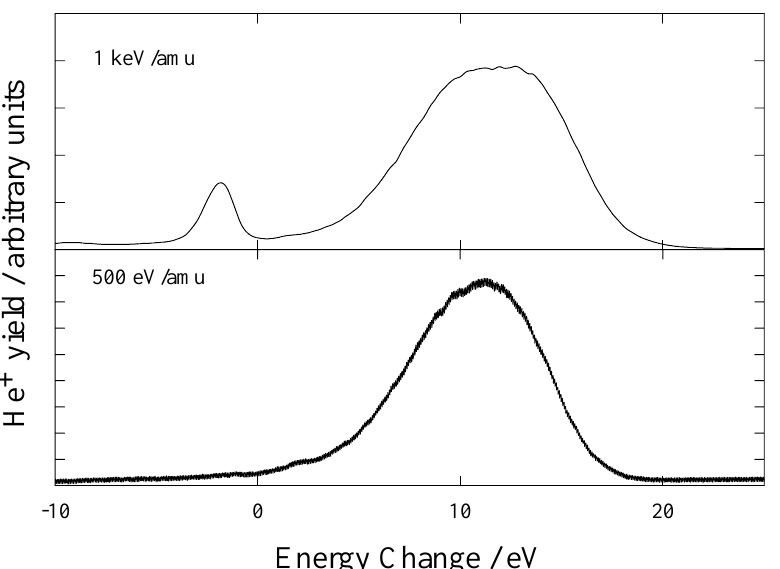
at 1 keV/amu and 500 eV/amu. 2